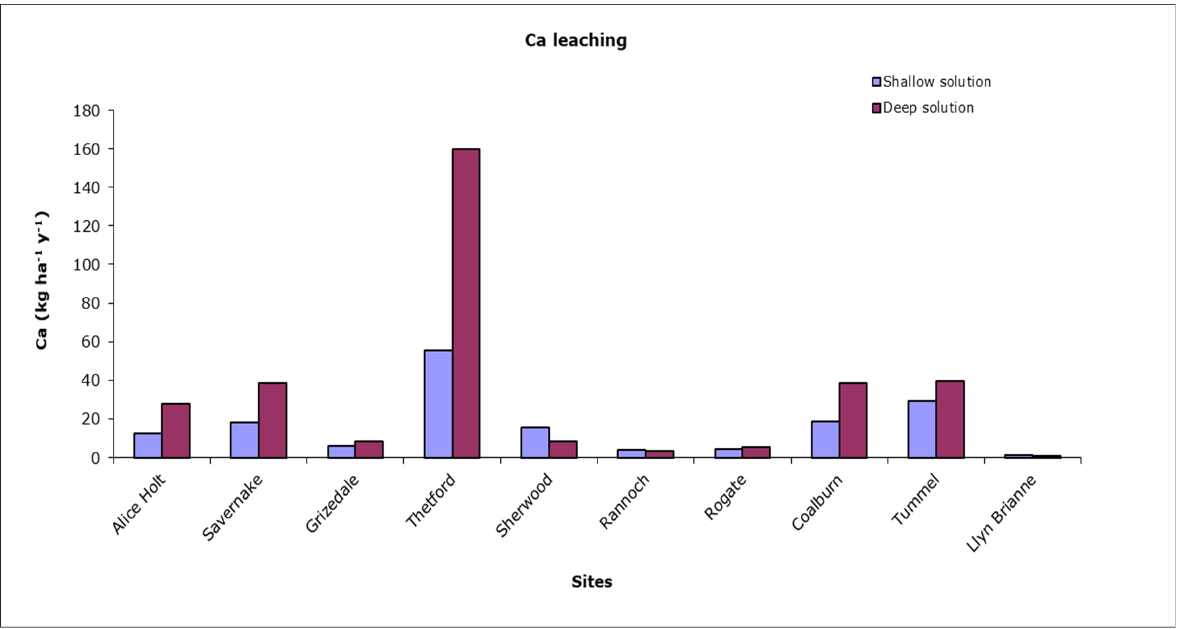
Figure 3. Calcium leaching flux at shallow (10 cm depth) and deeper (50 cm depth) soil depths at the ten ICP Forest Level II monitoring sites.